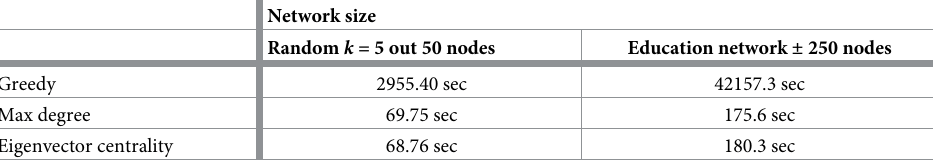
Table 3. Computation time of the different heuristics in a generated network and in the Education network.